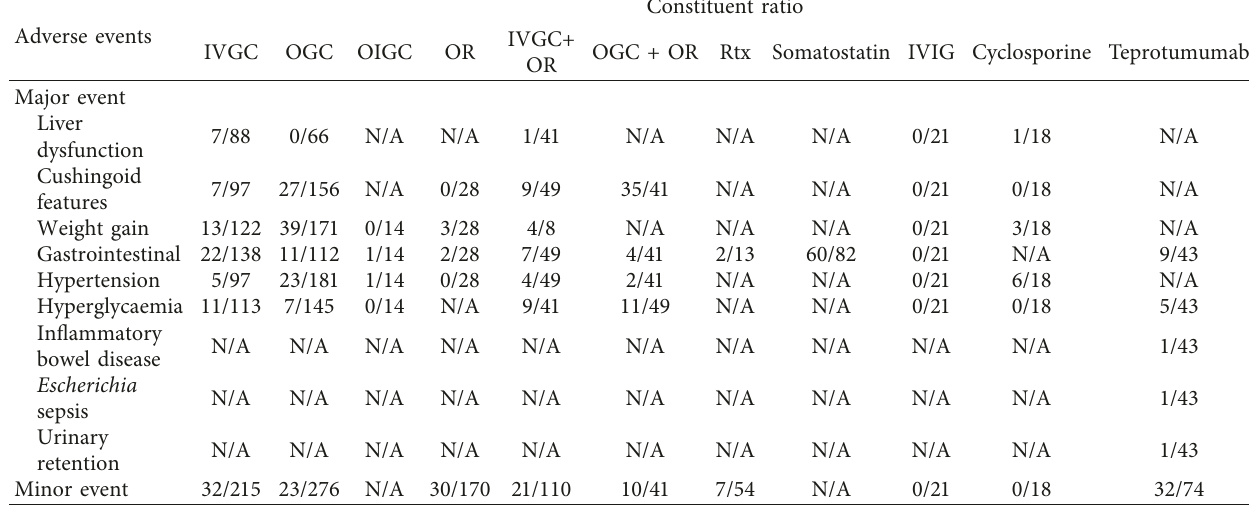
Table 3: Overall adverse events in all treatment